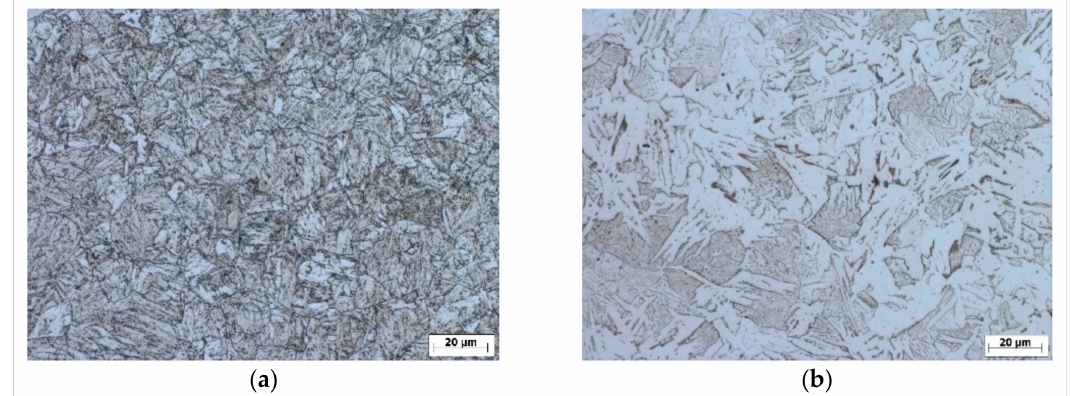
Figure 4. Microstructure over the cross section of the Tempcore bar φ 25 ( a ) surface and ( b )